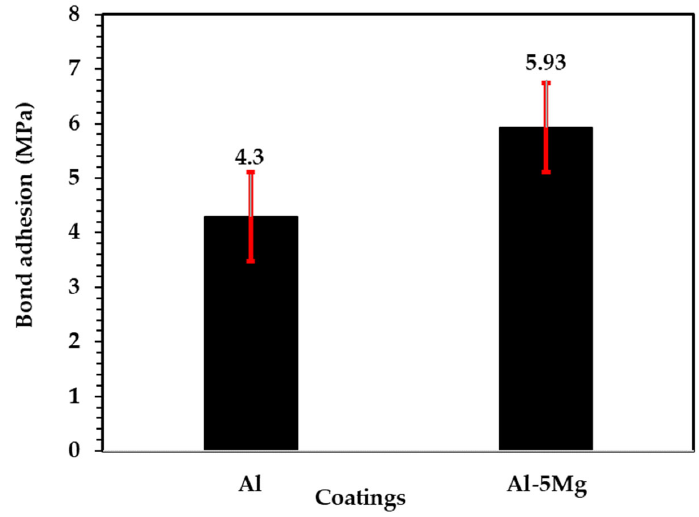
Figure 1. Bond adhesion values of the coatings.